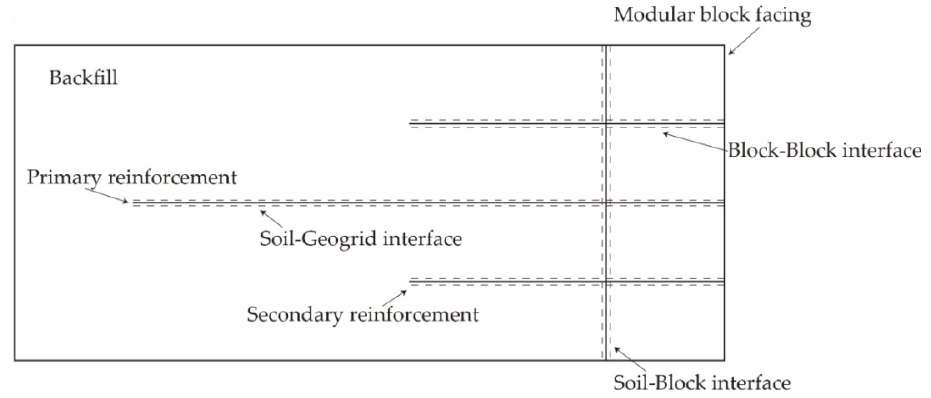
Figure 2. Schematic of the secondary reinforcement installation.